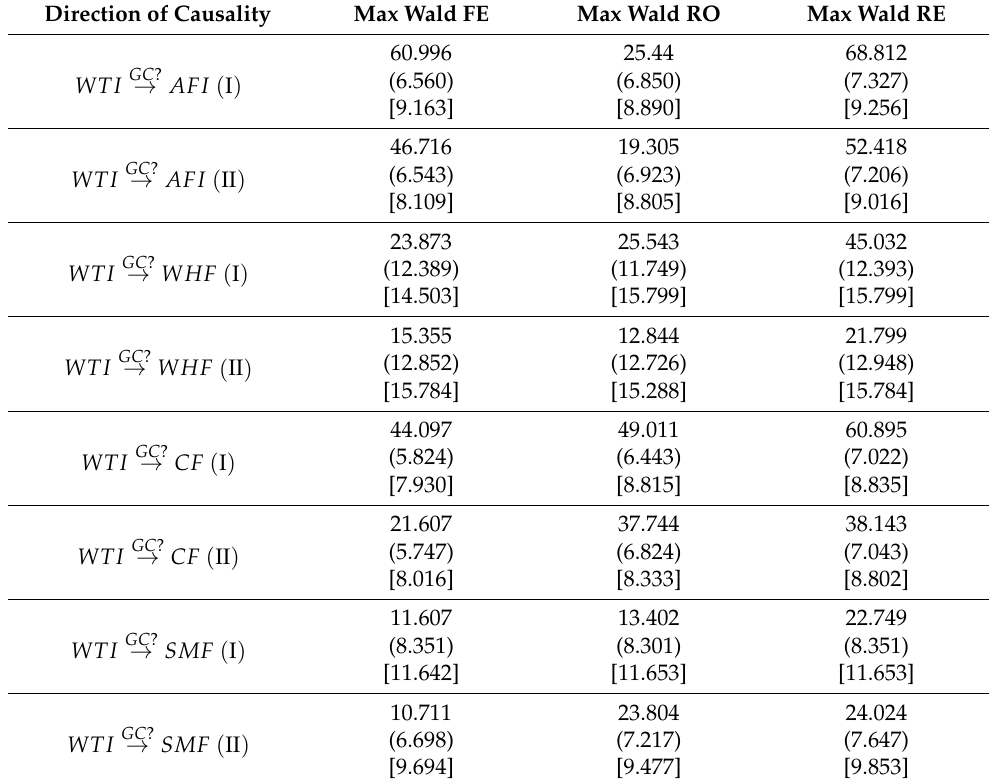
Table 7. Wald test results for time-varying Granger